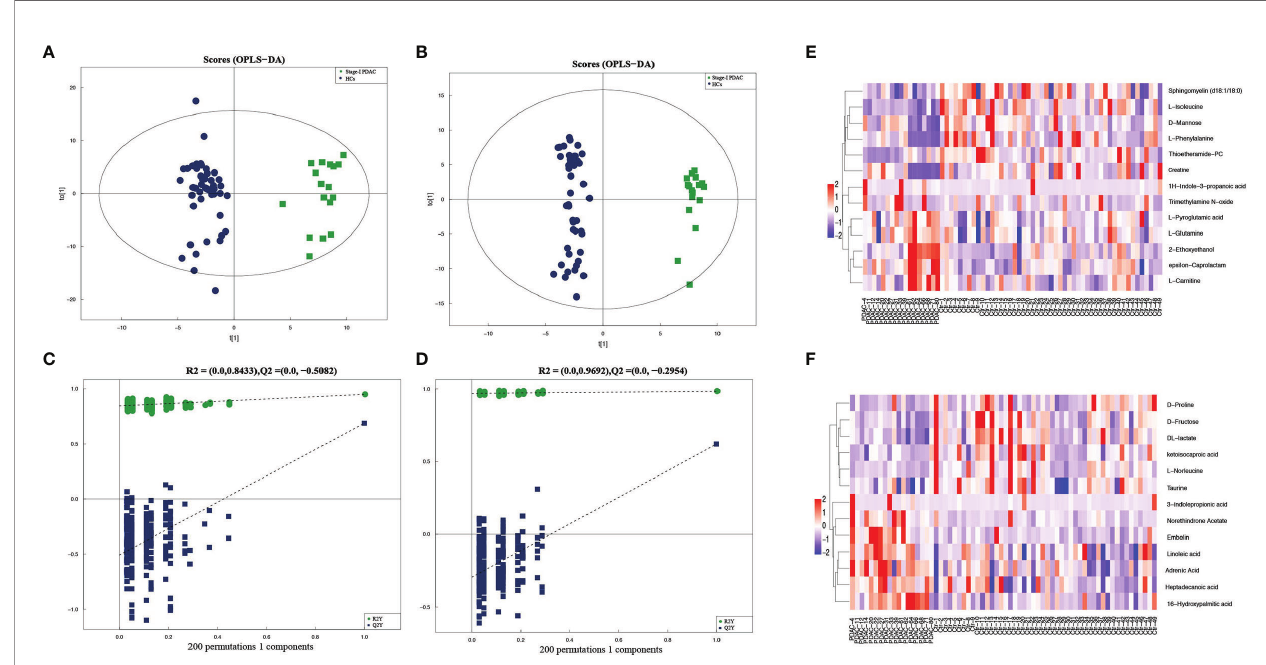
FIGURE 2 | (A, B) Serum metabolic pro fi les resulting from OPLS-DA in positive and negative ion mode. (C, D) The statistical validation of the corresponding OPLS- DA models (both in positive and negative ion mode) by permutation tests (200 times). (E, F) Heatmaps of prominent differential metabolites from stage-I PDAC versus normal controls in serum samples in positive and negative ion